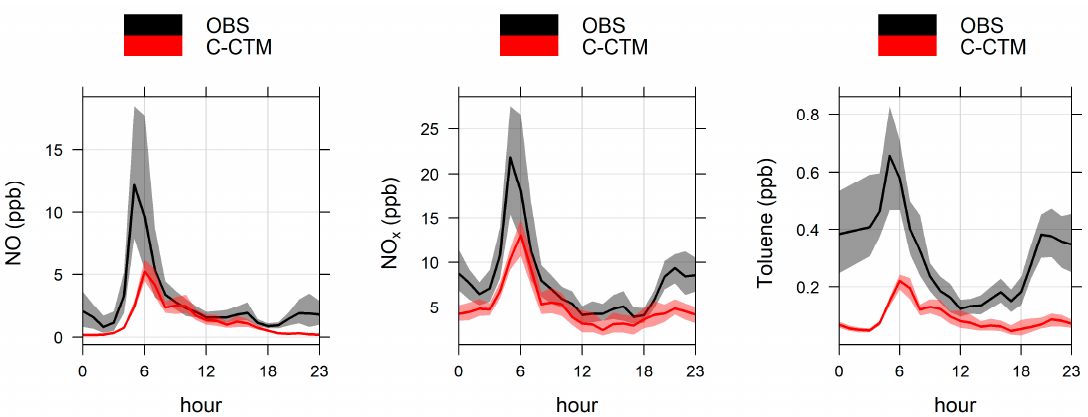
Figure 7. Average daily variations of mean mole fractions of NO, NO x and toluene during the campaign. Observations are shown in black and simulations using C-CTM are shown in red, with the dark central line representing the mean and the shaded area the 95% confidence interval.